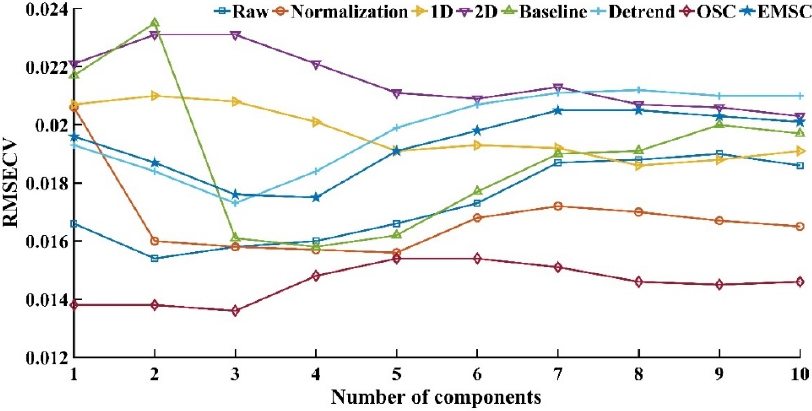
Figure 4. Cross-validation results under different spectral preprocessing